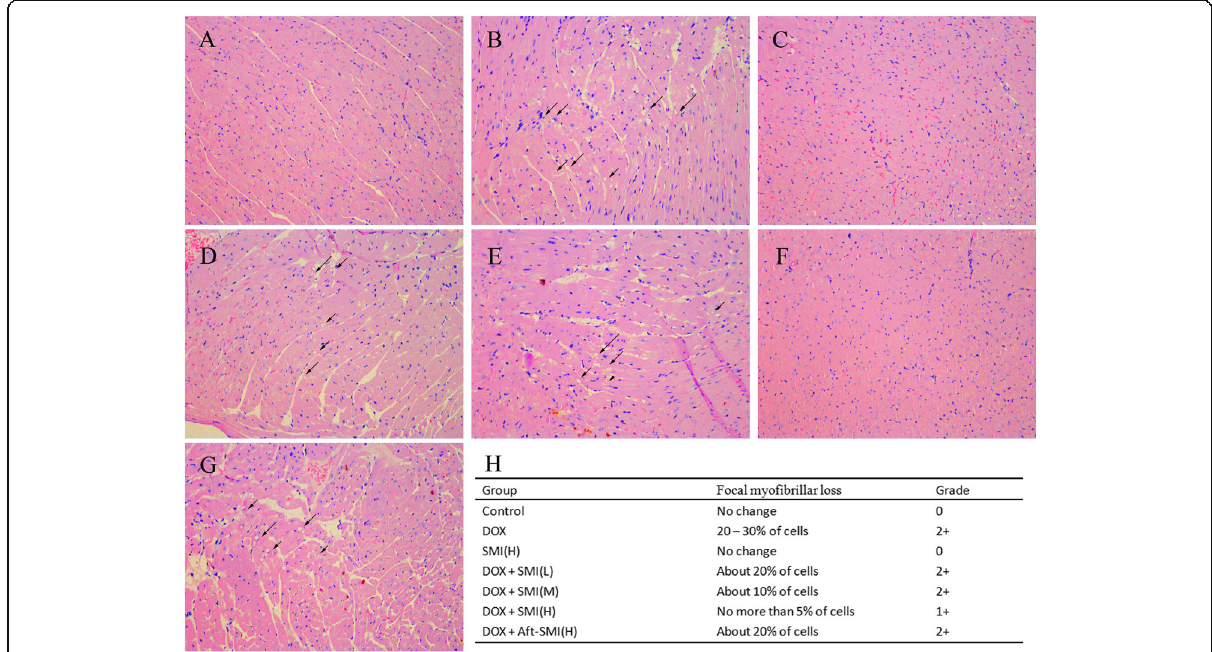
Fig. 5 Representative photomicrographs of cardiac tissue from control group ( a ), DOX group ( b ), SM injection group ( c ), co-treatment with DOX and SMI (0.5 g/kg) group ( d ), co-treatment with DOX and SMI (1.5 g/kg) group ( e ), co-treatment with DOX and SMI (5 g/kg) group ( f ) and the co- treatment with DOXand SMI (5 g/kg)) after treating ( g ). Co-treatment DOX and SMI on cardiac damage score ( h ). Cytoplasmic vacuolation and gentle inflammatory infiltration in the DOX treatment were attenuated by SMI. (HE ×